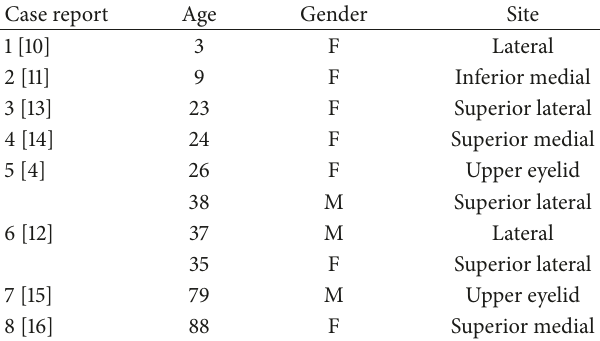
Table 1: Primary choristomatous respiratory orbital